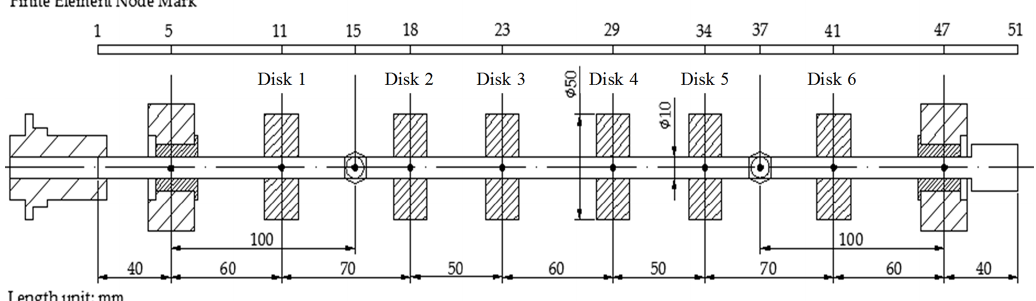
Figure 2. Finite-element division of the rotor.